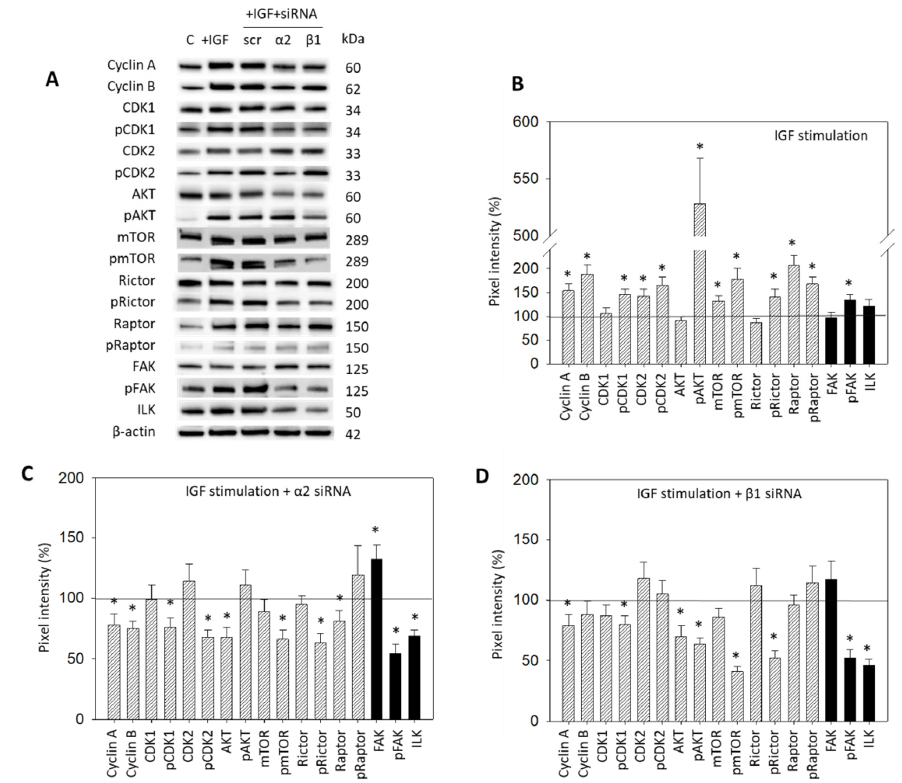
Figure 7. ( A ) Protein profile of cell cycle regulating proteins (AKT, mTOR, Rictor, Raptor, all total and phosphorylated, “p”), CDK1 and 2 (total and phosphorylated, “p”), Cyclin A and B, FAK, pFAK and ILK. HepG2 cells were either stimulated with IGF or stimulated with IGF and treated with an integrin α 2 or β 1 specific siRNA (scr = scrambled siRNA). Following siRNA transfection protein data of integrin α 2 and β 1 are shown on the right side of Figure 4A. Controls ( C ) received cell culture medium alone. One representative experiment of three is shown; ( B ) Quantification of the protein intensity in IGF1 treated versus non-treated HepG2 cells by the pixel density analysis, all related to the unstimulated 100% controls. * significant difference to controls; ( C,D ): Pixel density analysis of the protein level in HepG2 cells following α 2 ( C ) or β 1 ( D ) siRNA knock-down. Values are given in percentage, related to the 100% control. * significant difference to controls.